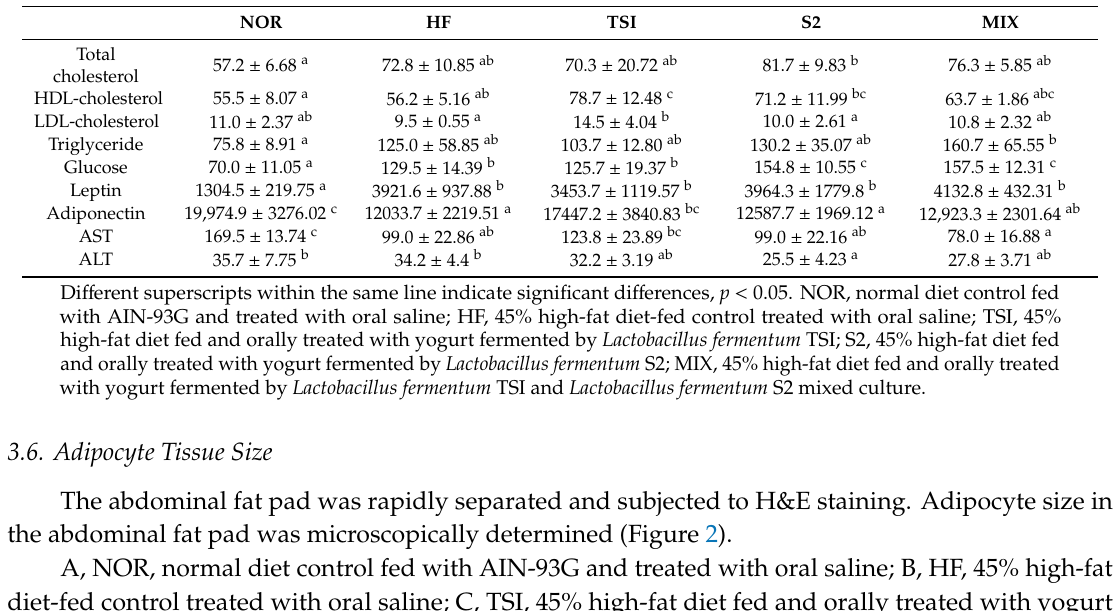
Figure 2. Representative hematoxylin and eosin staining of omental adipose tissue (OMAT) in SD rats exposed to experimental diet for 8 weeks (original magnification, × 200). A, NOR, normal diet control fed with AIN-93G and treated with oral saline; B, HF, 45% high-fat diet-fed control treated with oral saline; C, TSI, 45% high-fat diet fed and orally treated with yogurt fermented by Lactobacillus fermentum TSI; D, S2, 45% high-fat diet fed and orally treated yogurt fermented by L. fermentum S2; E, MIX, 45% high-fat diet fed and orally treated with yogurt fermented by L. fermentum TSI and L. fermentum S2 mixed culture. The adipocyte size of HD-fed groups varied widely in comparison with that of the NOR group at the same magnification level. Rats fed with fermented yogurt had smaller adipocytes than those in the HF group. Concurrently, numerous studies have reported that adipocyte size is increased during obesity [35,36]. Each cell was imaged ten times and the average adipocyte size was measured using ImageJ software (Figure 3).